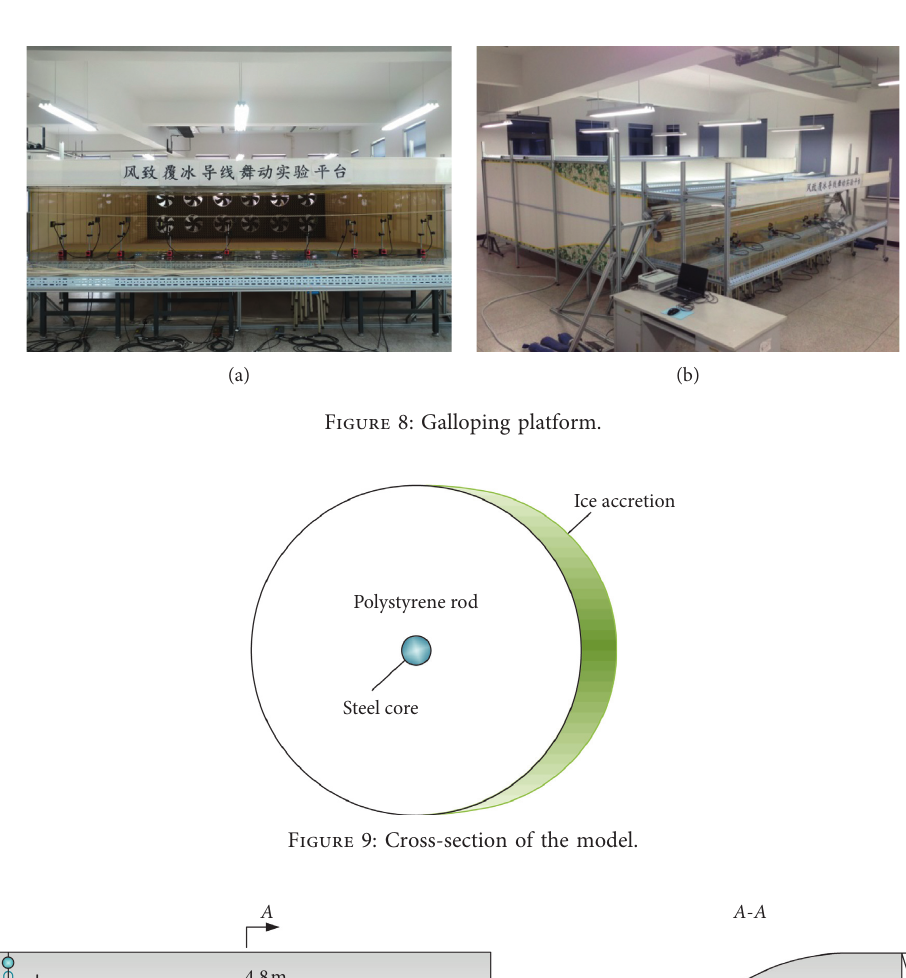
Figure 7: Time history of the first in-plane modal galloping with wind speed reduction at U (c) t d � 5s.